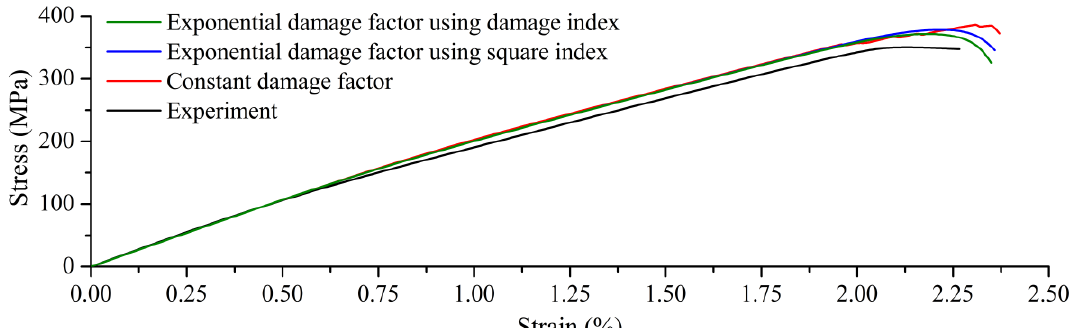
Figure 6. Experimental versus three numerical stress-strain responses.